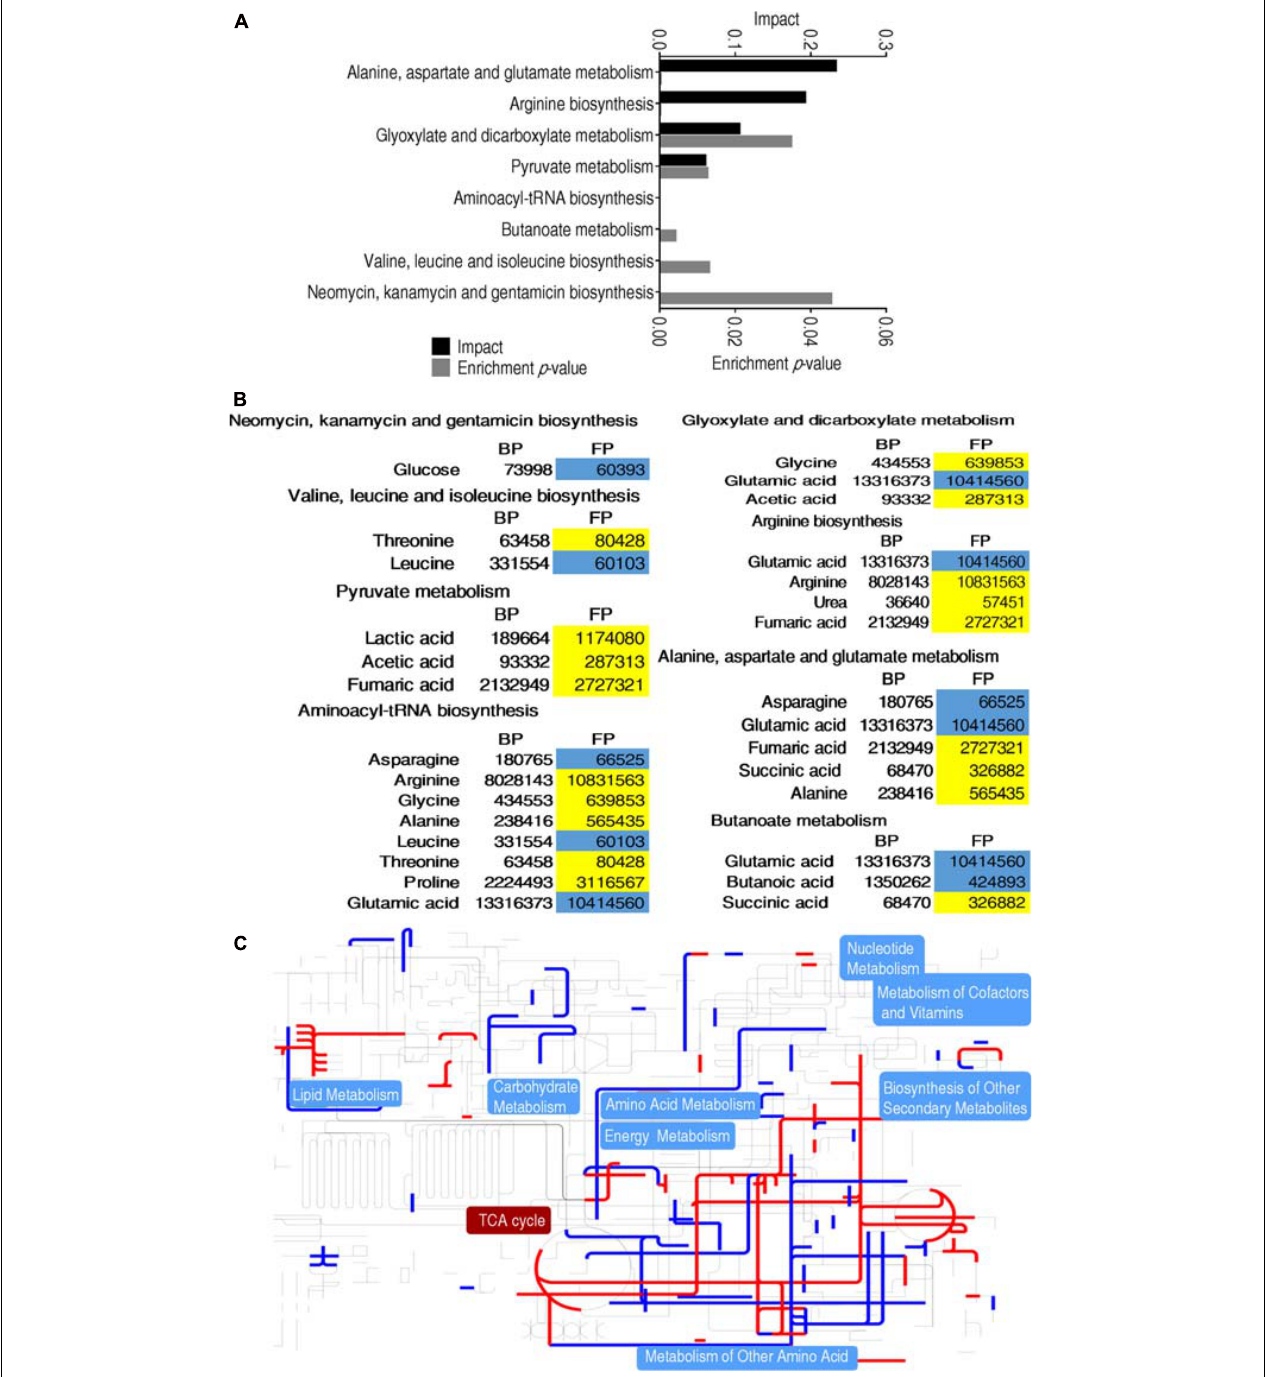
FIGURE 3 | Metabolomic alterations at different groups. (A) Pathway enrichment analysis of differential metabolites that were used for visualization. (B) Heat map of differential metabolites. Yellow indicates an increase in metabolites and blue indicates a decrease, which were represented by the average and standard deviation of the metabolite relative abundance. (C) iPath analysis of the differential